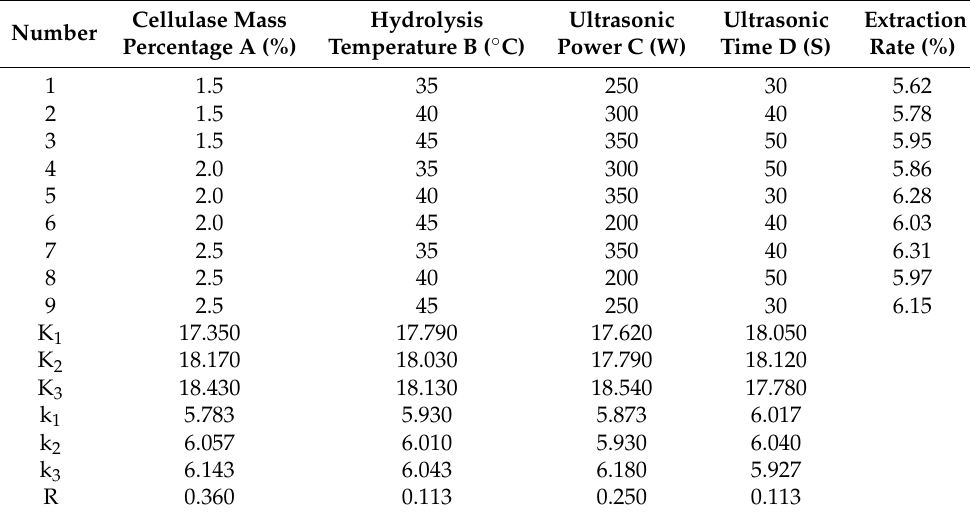
Table 3. The results of the orthogonal test.